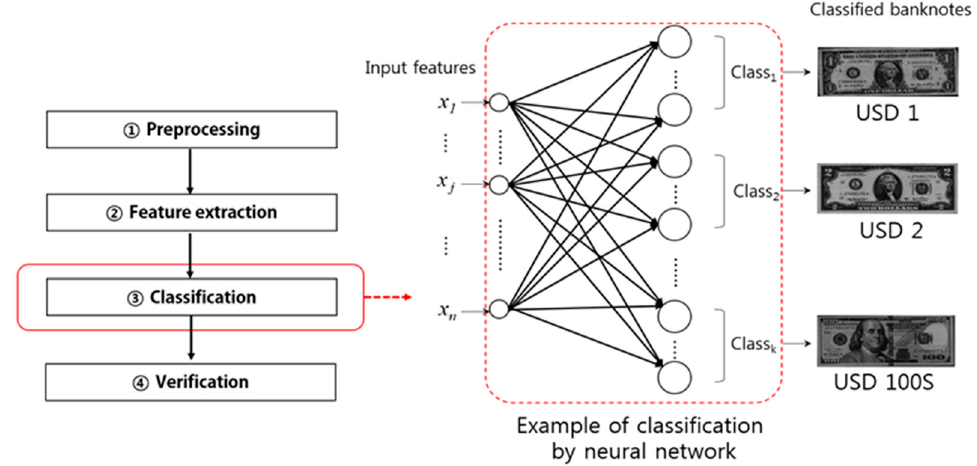
Figure 8. Classification example in the banknote recognition process flow. Table 4. Studies on classification and verification in the banknote recognition process